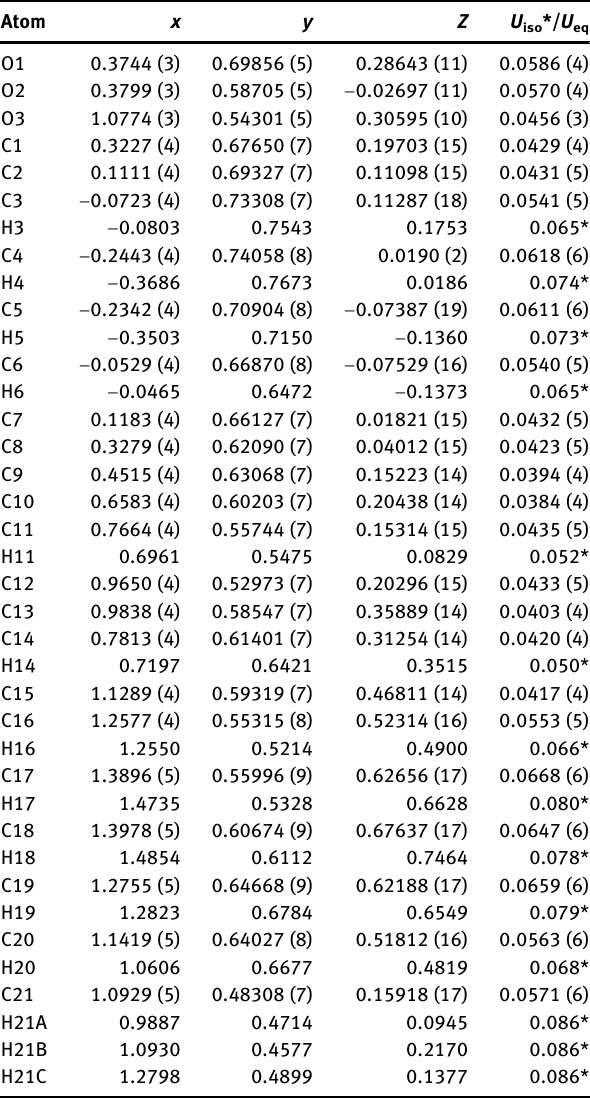
Table  : Fractional atomic coordinates and isotropic or equivalent isotropic displacement parameters (Å 